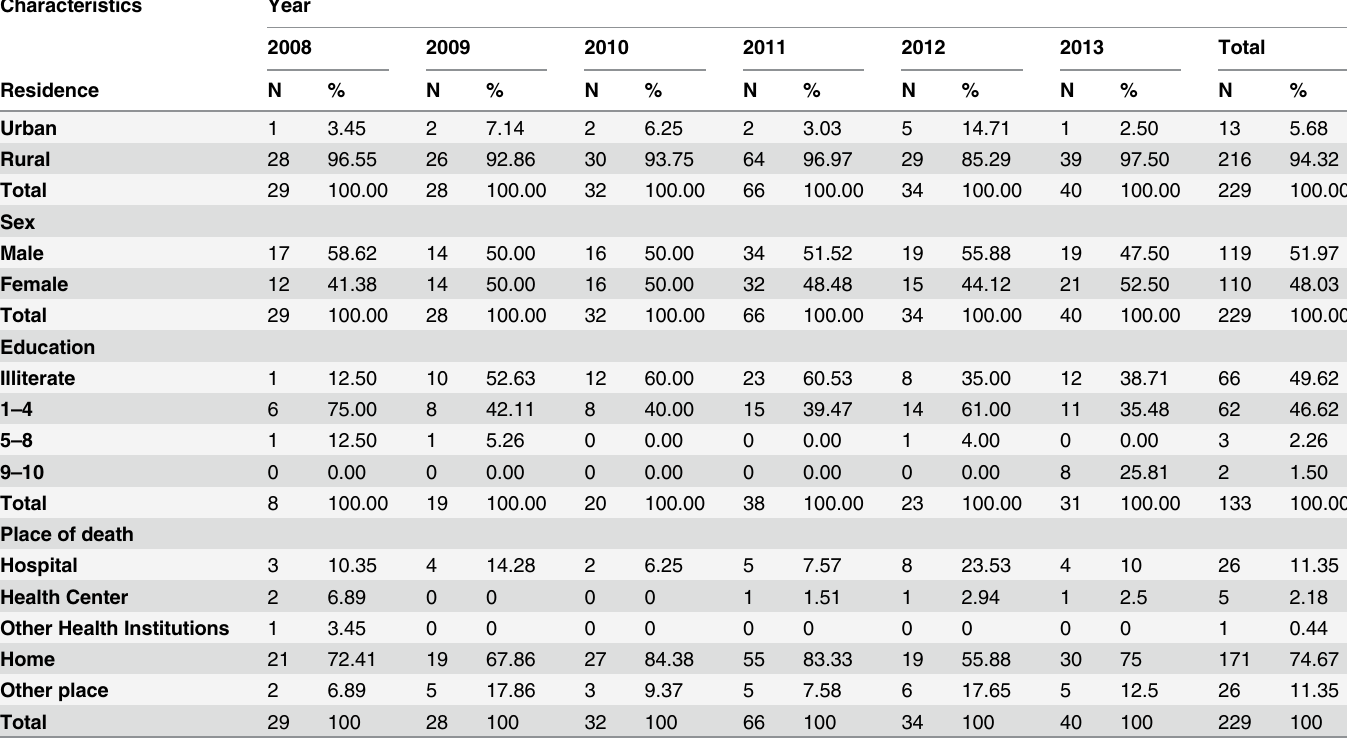
Table 1. Socio-Demographic Characteristics and place of death of the deceased by year among 5 to14 year olds, Kersa HDSS, 2008 – 2013.